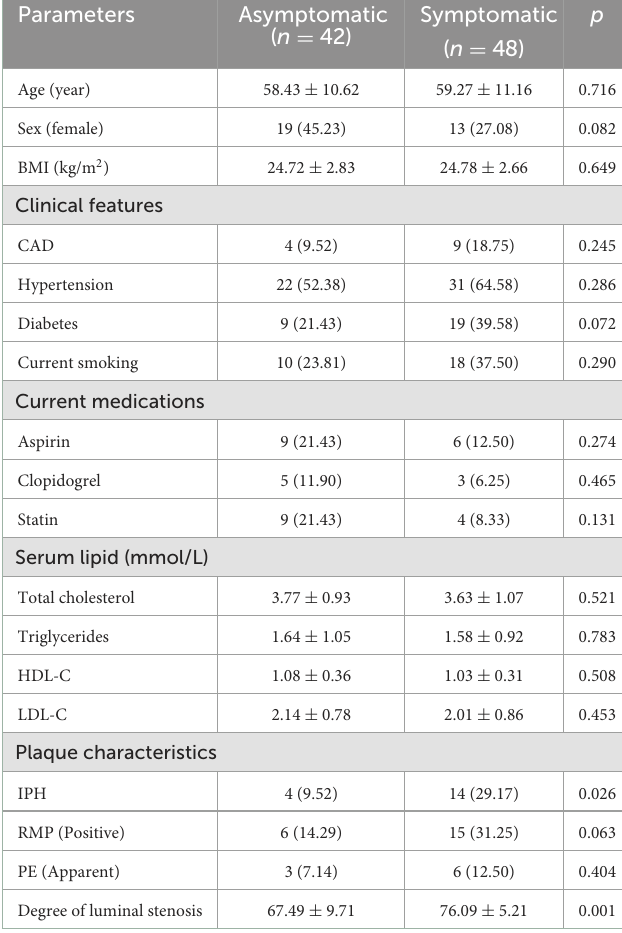
TABLE 1 Clinical and radiological characteristics of